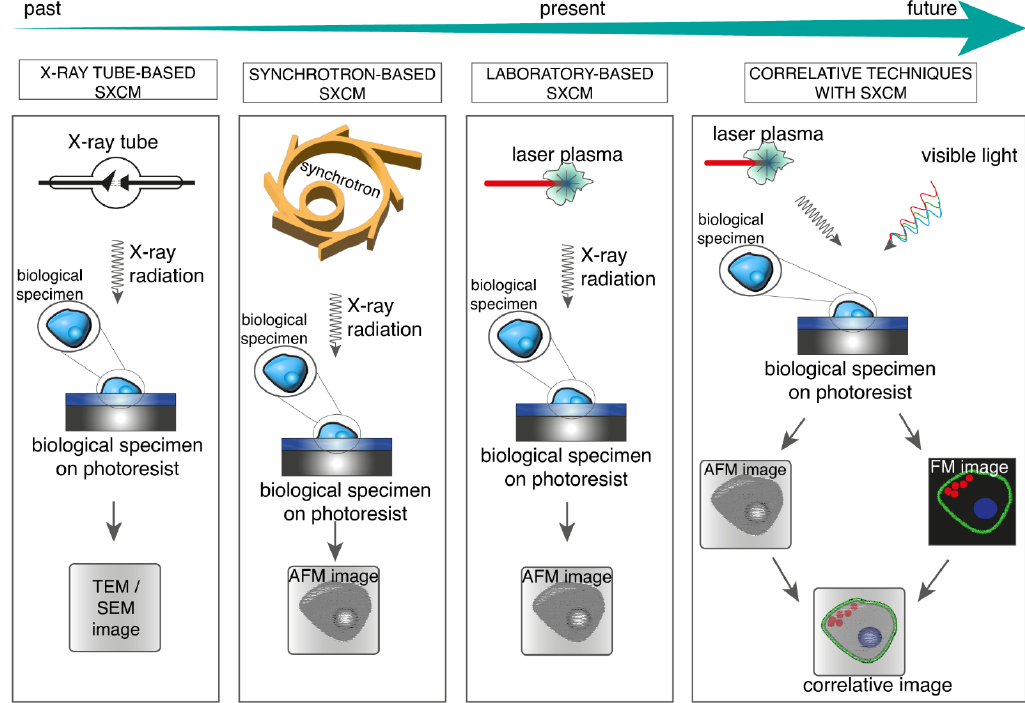
Figure 5. The anticipated development of SXCM. The development of compact X-ray sources makes SXCM much cheaper, smaller, and easier to use in biological laboratories. The correlation of SXCM with other developing microscopic techniques, such as optical, fluorescence, and super-resolution microscopy, improves the identification of various biological structures and provides additional information on their distribution and